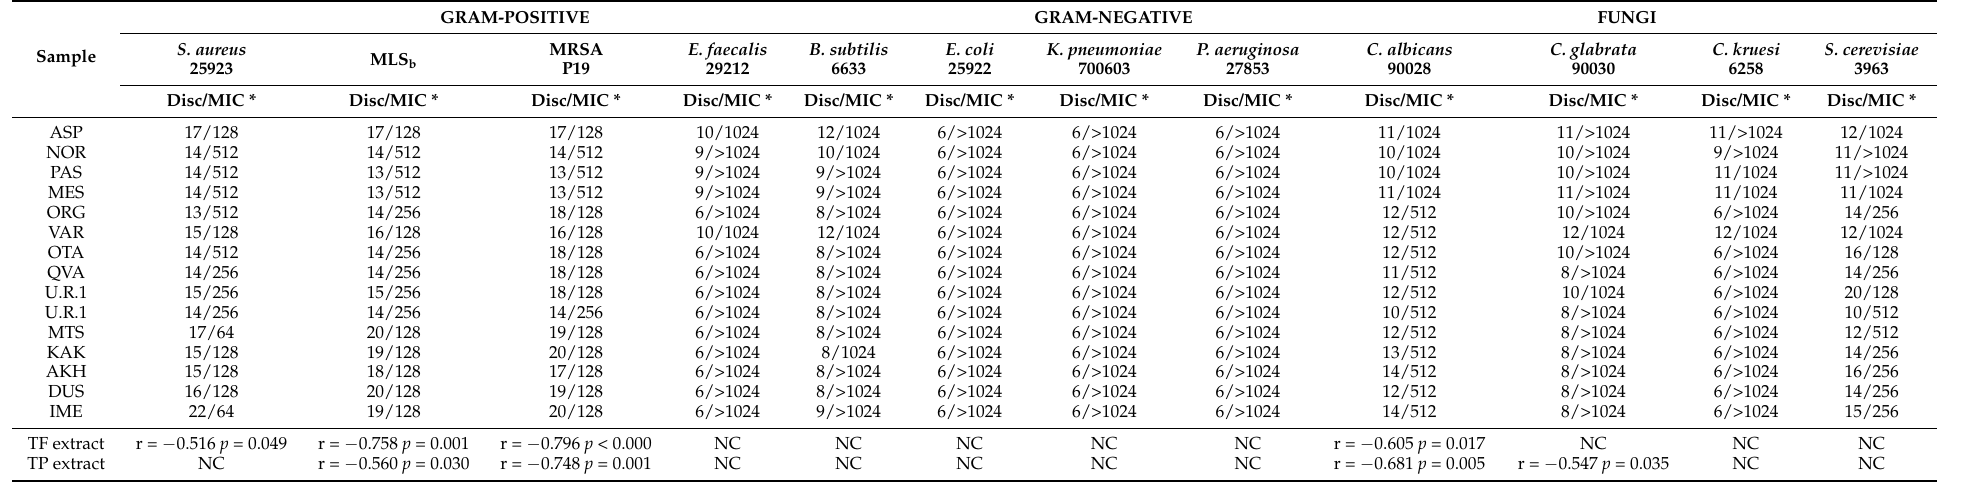
Table legend: Disc/MIC—Kirby–Bauer disc diffusion method/minimal inhibitory concentration; * values of disc diffusion (Kirby–Bauer method) was presented as mm of inhibition diameter zones, while MIC was described in µ g/mL. All antibacterial test values was means of three repetitions; NC—no correlation, p > 0.05; TF—flavonoid content; TP—total